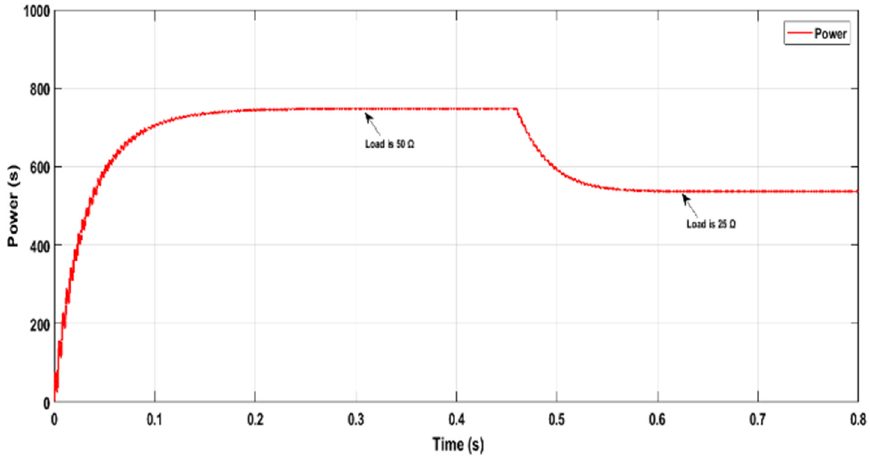
Figure 11. Load switching for the IT2FLC technique.